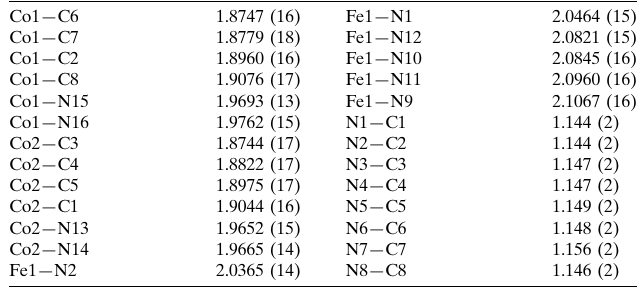
Selected geometric parameters (A˚ , (cid:3)